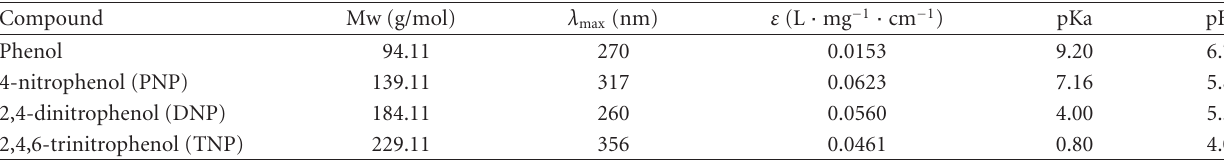
Table 1: Physicochemical characteristics of polynitrophenols.